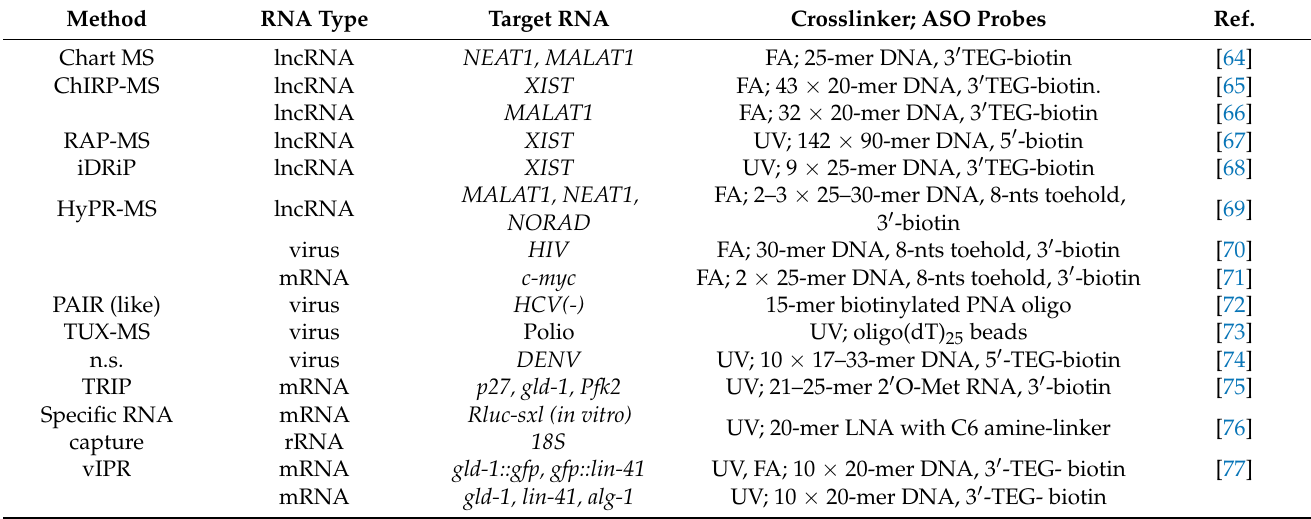
Table 1. ASO-based RNA-capture